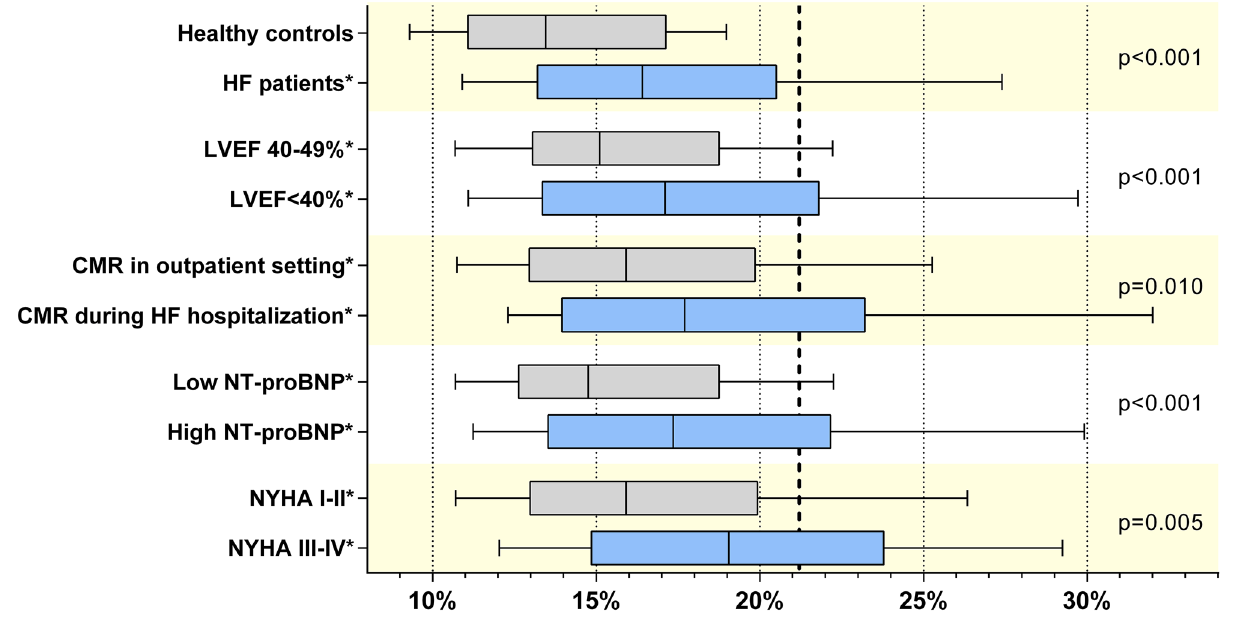
Figure 3. Distribution of LWD as per the following subgroups: (1) LVEF [reduced (< 40%) vs. midrange (40–49%) LVEF]; (2) functional class (NYHA I–II vs. III–IV); (3) NT-proBNP (> 600 or 900 pg/mL if AF vs. ≤ 600 or 900 pg/mL if AF); and (4) status at CMR acquisition (during HF hospitalization vs. outpatient); Box plots illustrating LWD median, 25th and 75th percentiles, and whiskers show the 10th and 90th percentiles; * p < 0.05 in comparison to control; p -values for LWD comparison between subgroups are shown in figure. CMR cardiac magnetic resonance, HF heart failure, LVEF left ventricular ejection fraction, NYHA New York Heart Association.